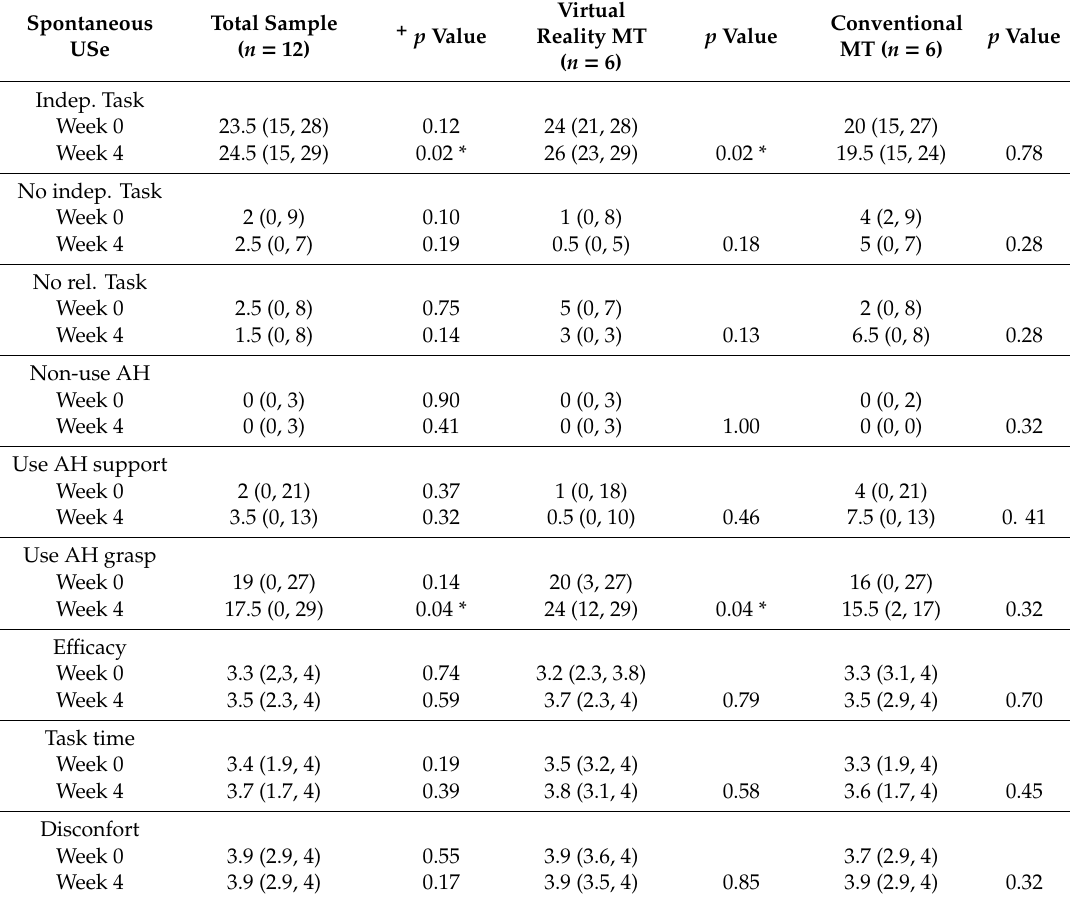
Table 5. Results of spontaneous use for Conventional MT and Virtual Reality